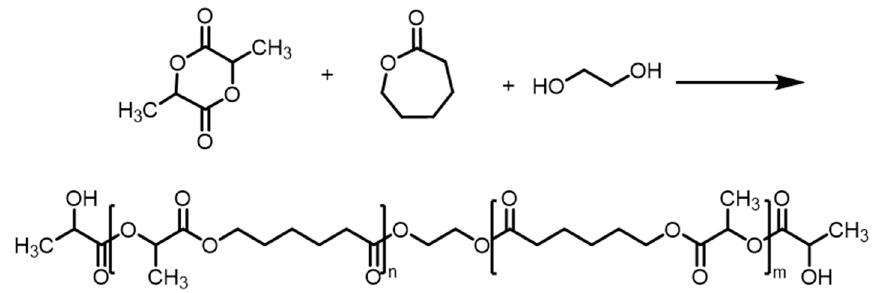
Figure 2. The synthesis of copolymers of lactide and caprolactone with ethylene glycol. Table 1. Monomer ratios of copolymer samples.